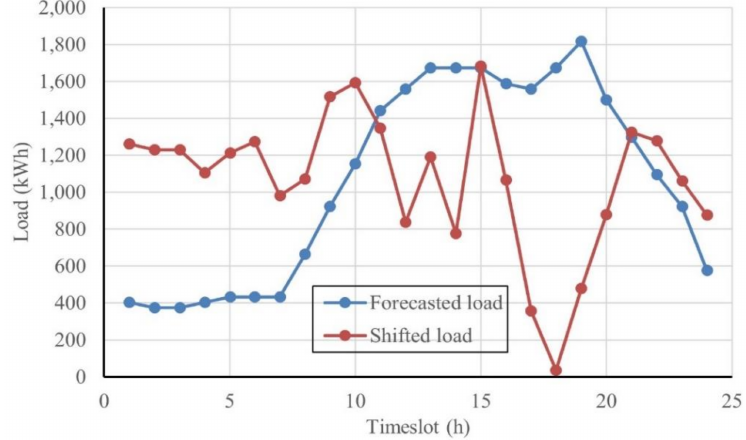
Figure 15. Hourly commercial load before and after DSM using the distributed algorithm RTP-SBY.